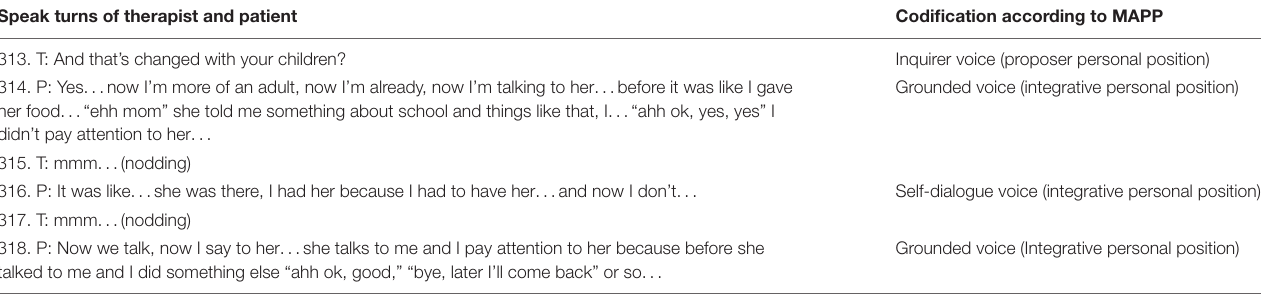
TABLE 4 | Excerpt of change episode number 55 (level 3) from session 44 of the patient and their codification according to MAPP (T, therapist; P, patient). Speak turns of therapist and patient Codification according to MAPP 313. T: And that’s changed with your children?